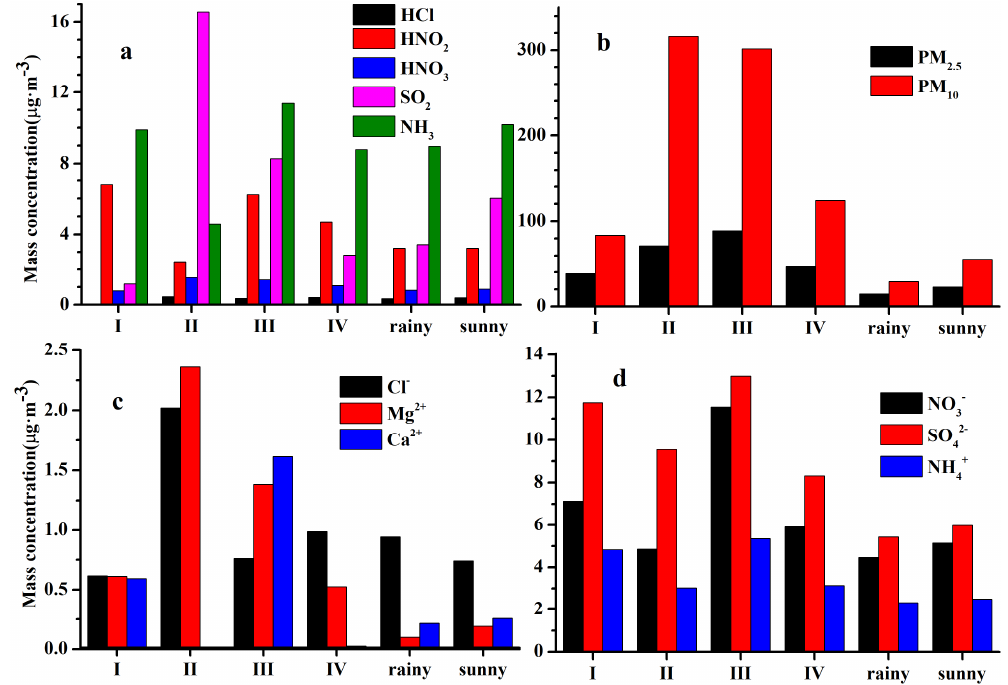
Figure 5. Concentrations of chemical components and PMs at different dust stages.